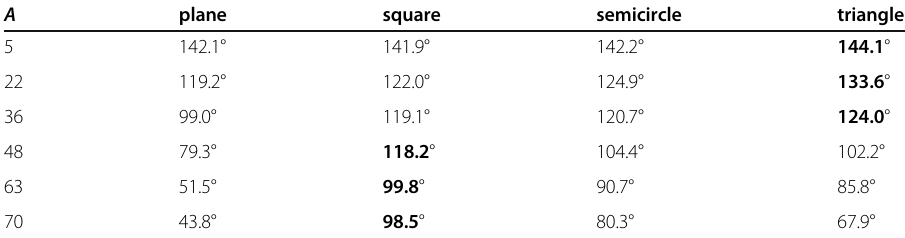
Table 4 Contact angles of 40ul droplets on surfaces of different microstructures A plane square